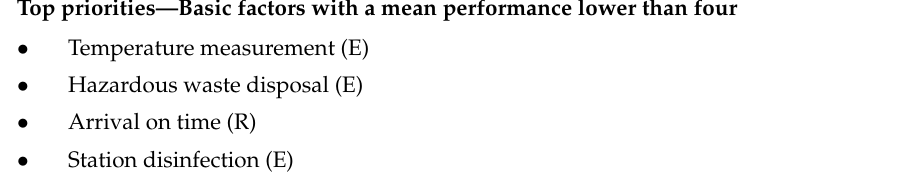
Table 8. Improvement priorities based on the three-factor theory. Service Quality